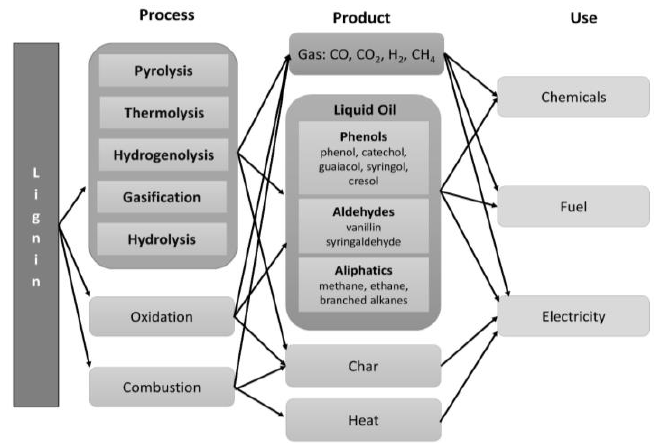
Figure 4. Major thermochemical lignin processes used to depolymerize lignin and the resulting products, as shown by Macfarlane et al. [188].